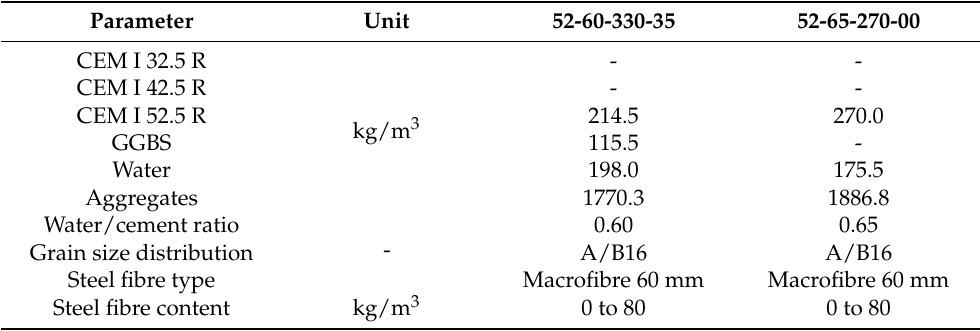
Table A9. Concrete mix designs for the multiple parameter variation—part 4.